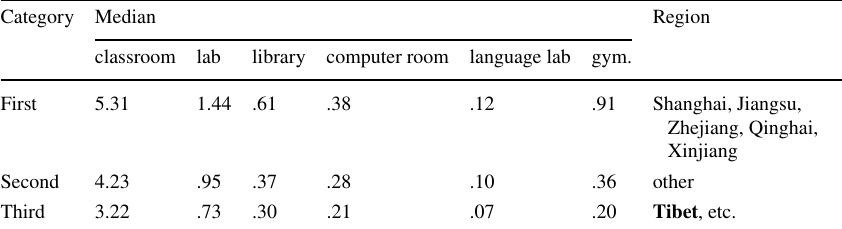
Table 10 Clustering of six indicators (junior high school) Category Median Region classroom